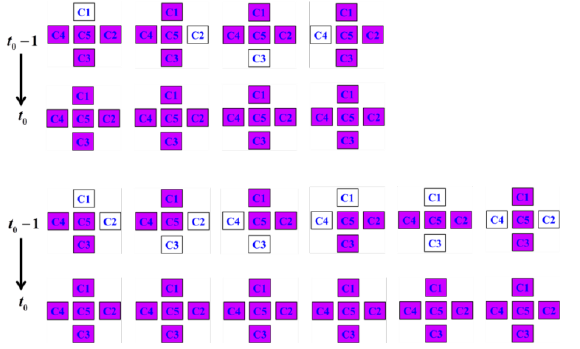
Figure 4. Explaining the third step of the CA model for Type I-Type I boundary considering the curvature-driven mechanism.